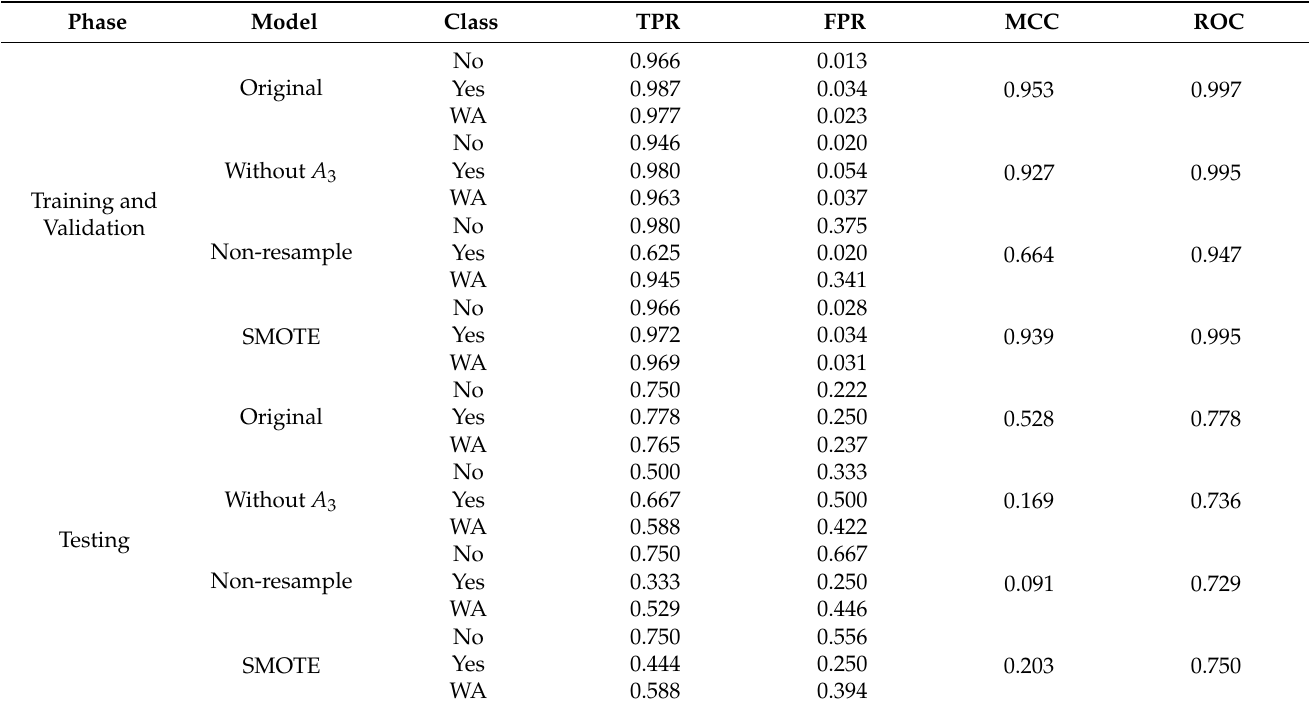
Table 14. Comparison of prediction performance of RF models in different conditions.